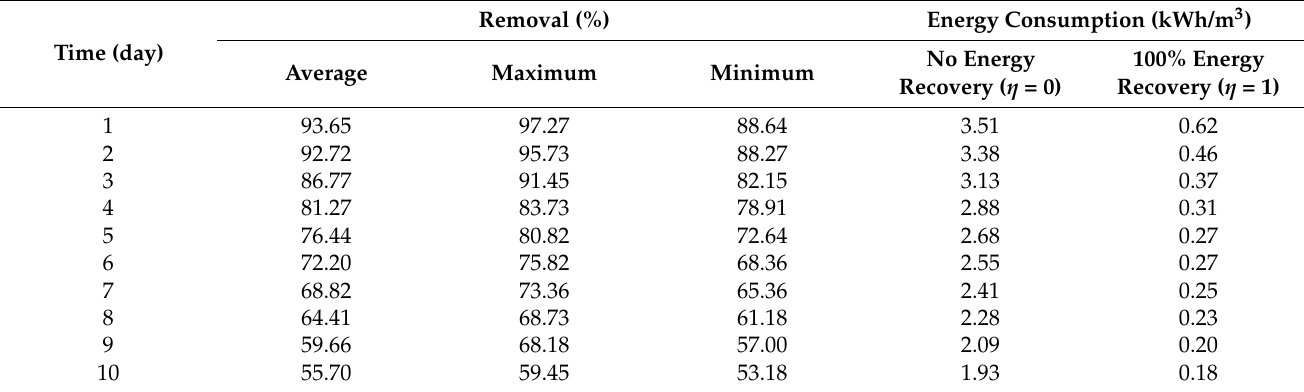
Table 10. Variations of TDS removal and energy consumption with time.